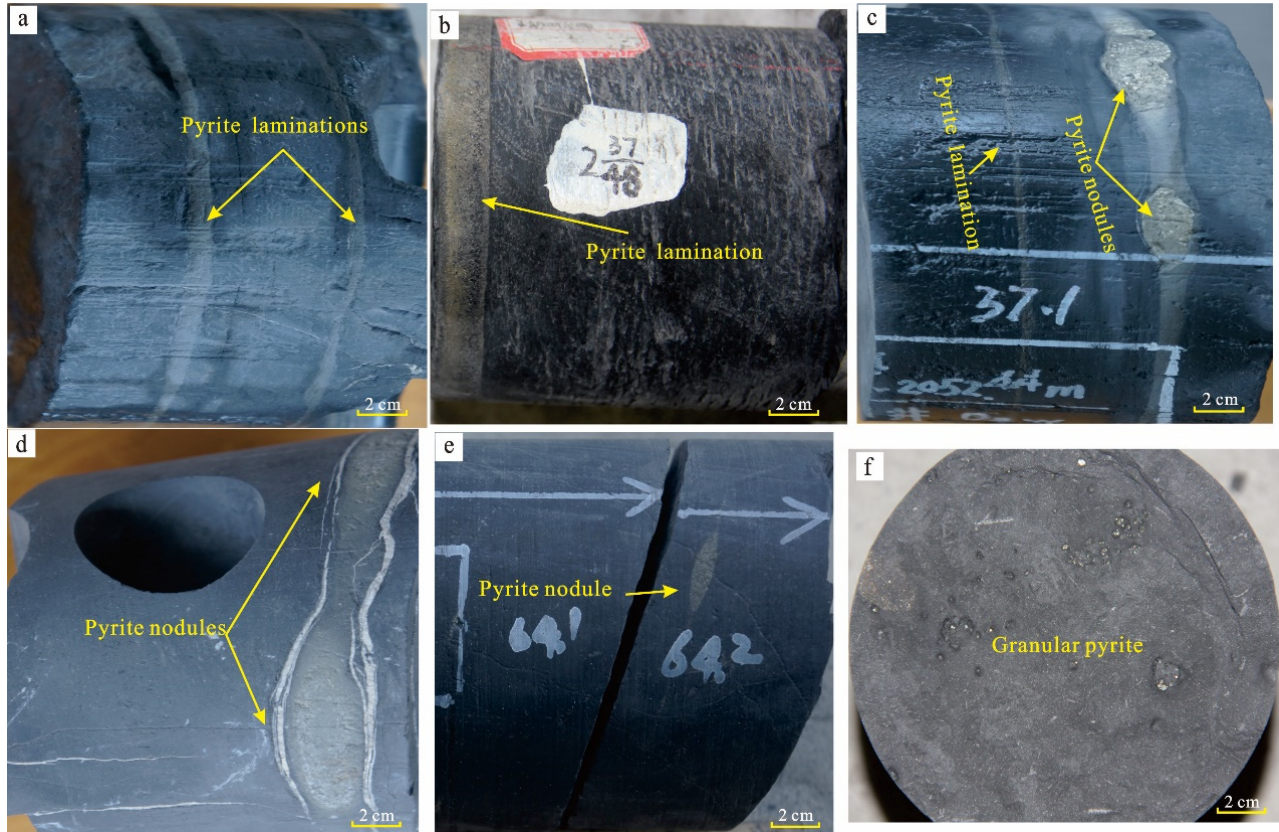
Figure 2. Macroscopical occurrence of pyrite in the Upper Ordovician Wufeng–Lower Silurian Longmaxi Formation. ( a ) Pyrite lamination in the Wufeng black shales, 72.40 m, X well. ( b ) Pyrite lamination in the gray silty shale of the Longmaxi Formation, 2338.6 m, JY1 well. ( c ) Lenticular pyrite developed within pyrite laminations in the Wufeng black shales, 70.44 m, X well. ( d ) Pyrite nodules show discontinuous distribution, 72.53 m, X well. ( e ) Pyrite nodules developed in the black silty shale of the Longmaxi Formation, 57.48 m, X well. ( f ) Pyrite lamination in the black carbonaceous shale of the Longmaxi Formation, 2355.8 m, JY1 well.